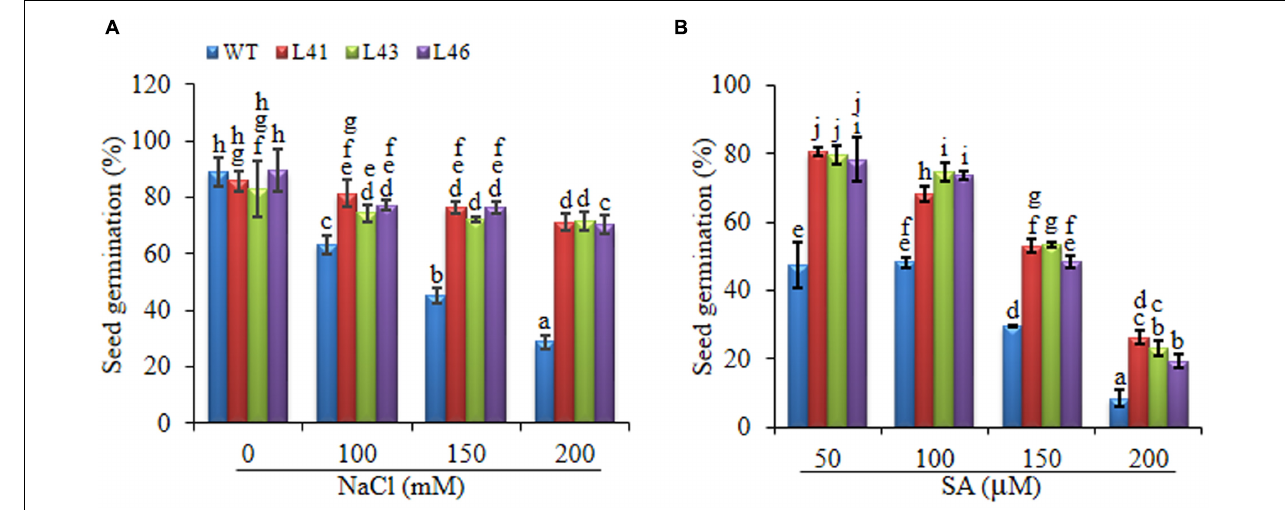
FIGURE 3 | Percentage seed germination at on different concentrations of (A) NaCl (0, 100, 150, 200 mM) and (B) SA (50, 100, 150, 200 µ M). Values are represented as mean ± SD ( n = 3) and marked with different alphabets to indicate significant difference at P ≤ 0.05 probability.